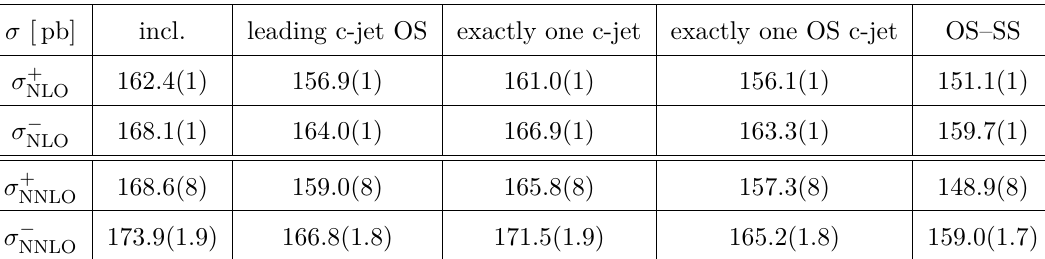
Table 5 . Fiducial cross sections at NLO QCD and NNLO QCD accuracy for different charm jet selections: at least one c-jet ( incl. ), leading c-jet is OS, exactly one c-jet, exactly one OS c-jet, and the OS–SS selection. The digit in parenthesis indicates the Monte Carlo statistical error.